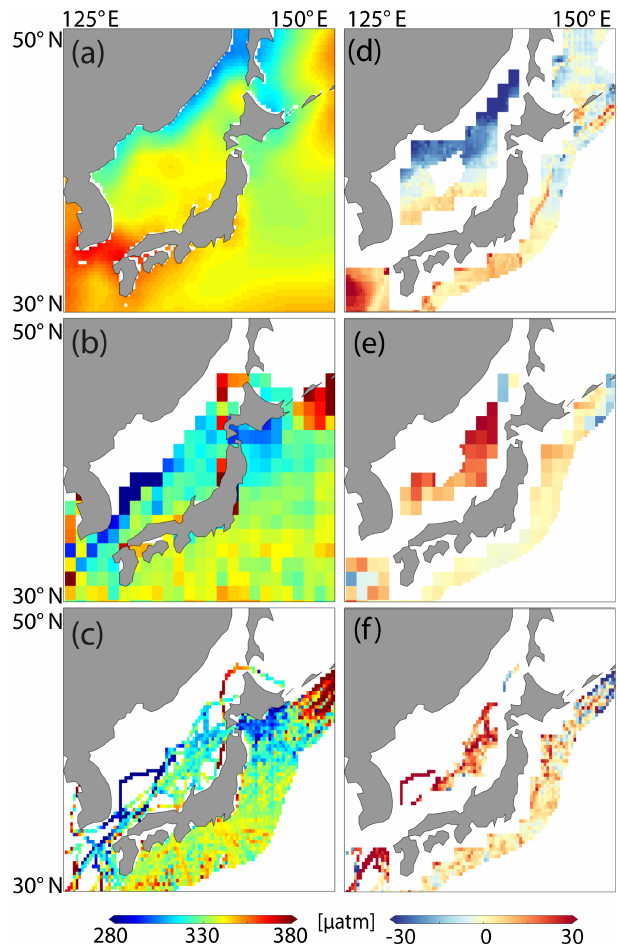
Figure 10. Mismatch analysis along the Sea of Japan region for the 1998 through 2015 period. The climatological mean p CO 2 is reported for (a) the merged product, (b) all available SOCATv5 data for the open ocean, and (c) all coastal SOCATv5 data (as illustrated in Fig. 1 for the global ocean). The p CO 2 mismatch is illustrated in (d) as the difference between NN coast and NN open . Panel (e) reports the mismatch between the NN open and the SOCATv5 open-ocean dataset along the overlap area, while panel (f) reports the mismatch between the coastal product and the SOCATv5 coastal dataset along the overlap